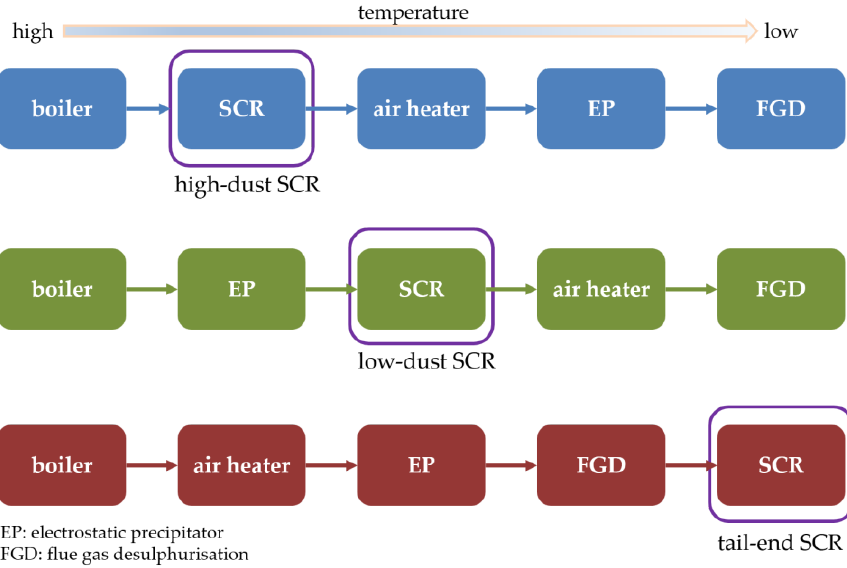
Figure 1. Types of SCR in the flue gas treatment system.